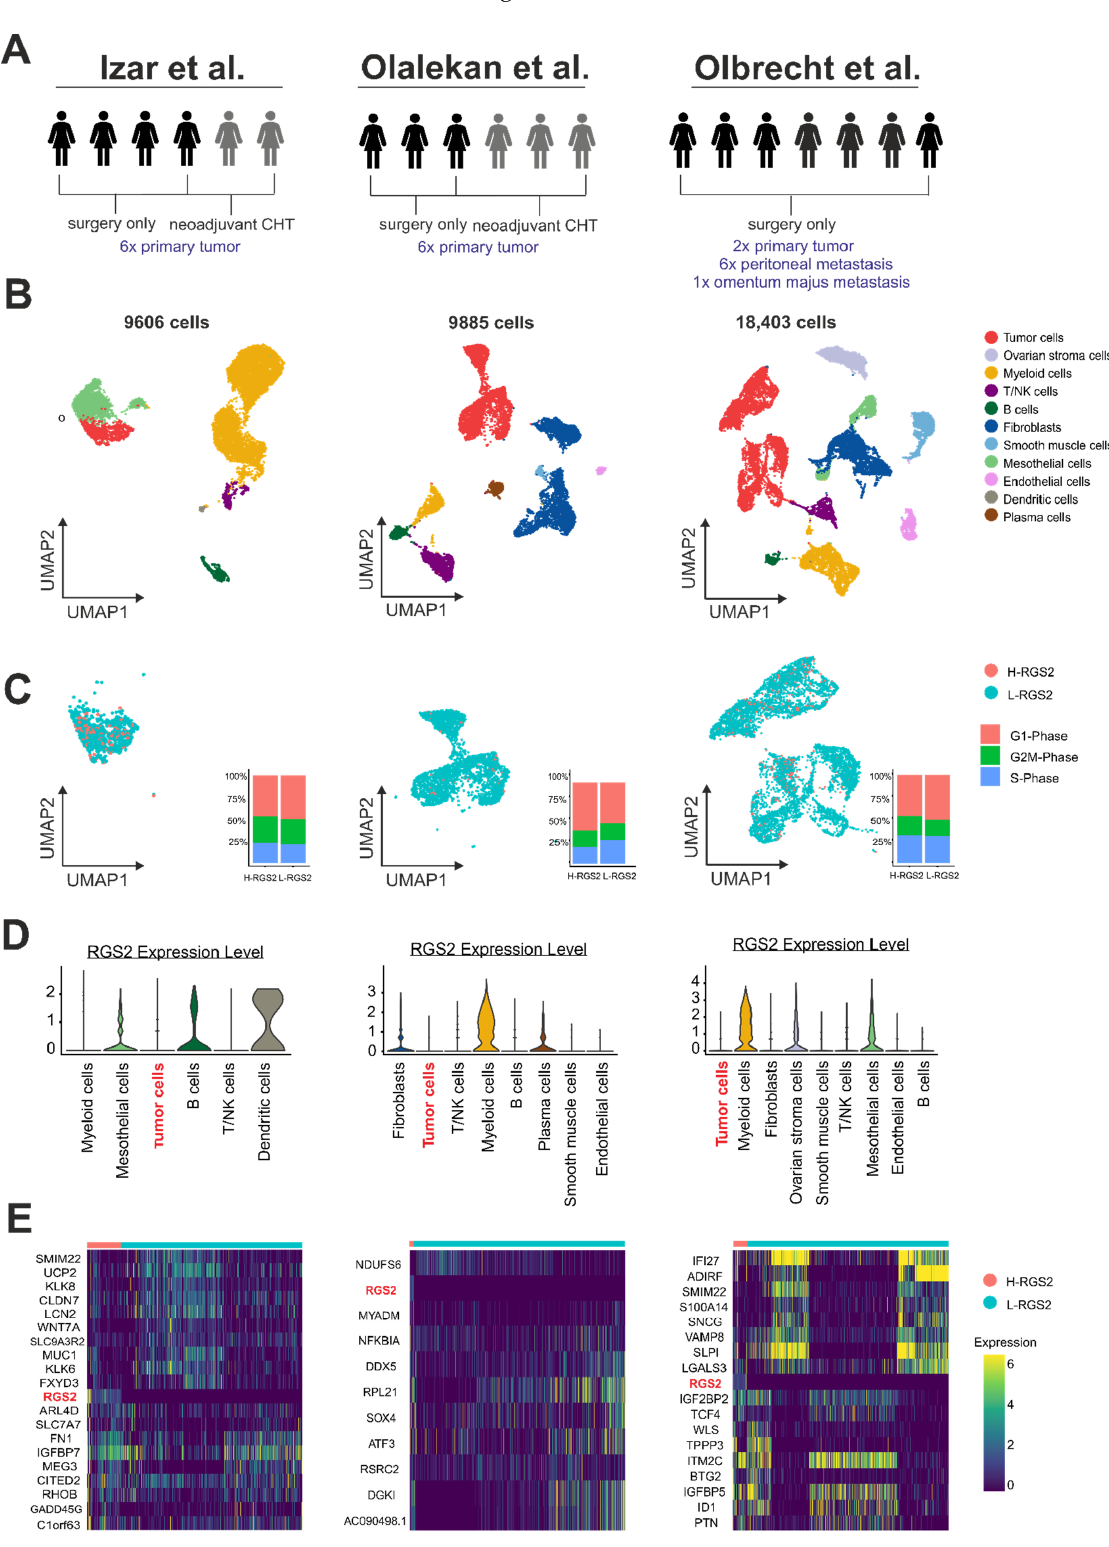
Figure 3. Single cell analysis with regard to RGS2 mRNA expression in three pre-existing datasets. ( A ) Composition of each HGSOC study cohort and tissue sampling sites, each manikin